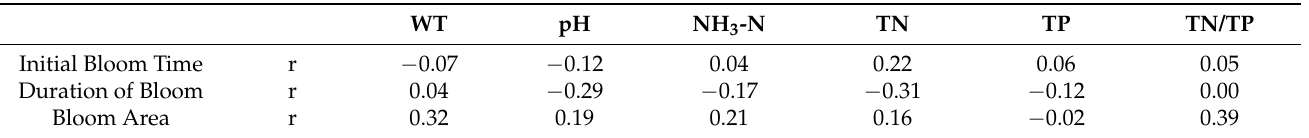
Table 3. Relationship between the initial bloom date, bloom duration, and bloom area in Lake Dianchi and water quality